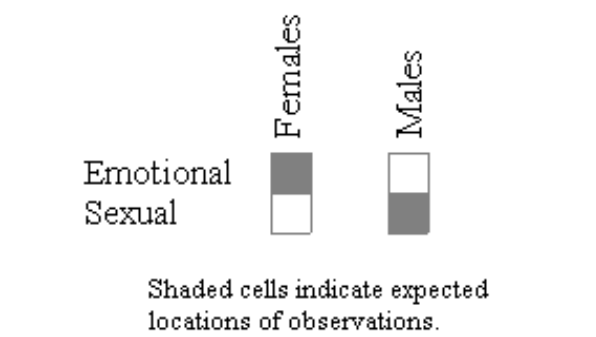
Figure 2. Expected pattern of observations according to evolutionary